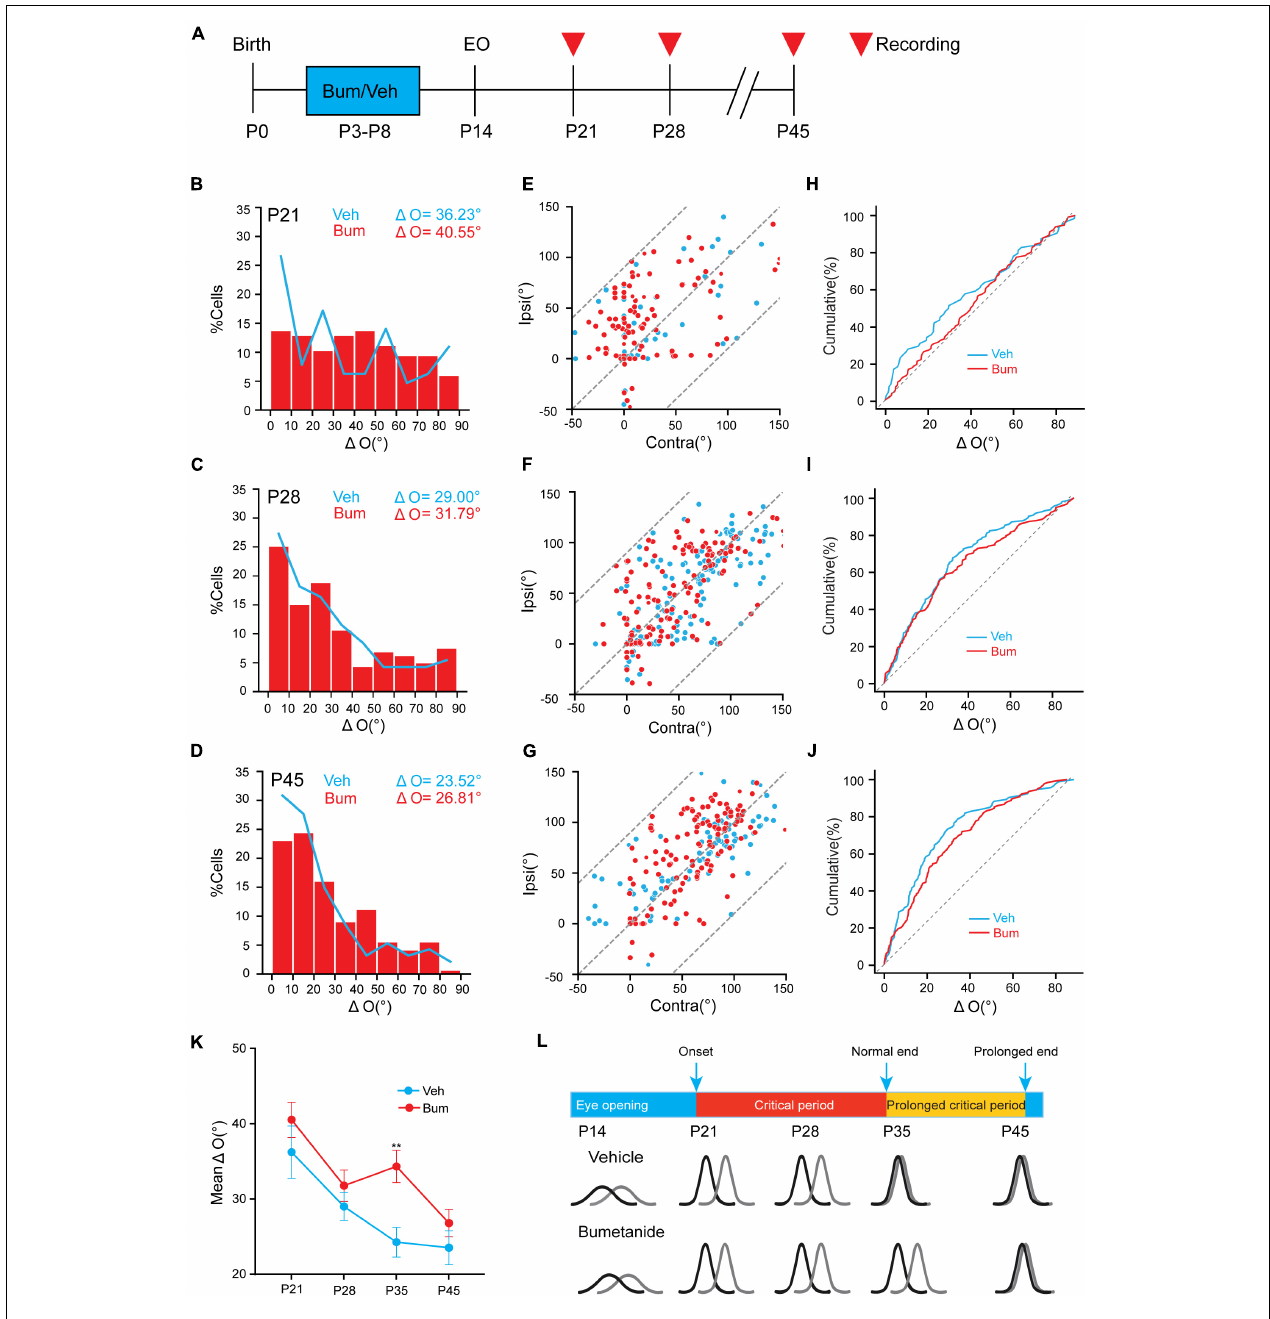
FIGURE 3 | Bumetanide treatment has no effect on binocular matching at other ages except for P35. (A) Schematic of three age groups (P21, P28, P45) recorded in Veh and Bum animals. Red triangle indicates in vivo electrophysiological recordings. (B–D) Distribution of difference in orientation preference in three different ages in Veh and Bum groups: (B) P21 in Veh (blue, (cid:49) O = 36.23 ± 3.46 ◦ , 65 cells,16 mice) and Bum groups (red, (cid:49) O = 40.54 ± 2.33 ◦ , 116 cells, 18 mice); (C) P28: in Veh ( (cid:49) O = 29.00 ± 1.86 ◦ ,165 cells, 11 mice) and Bum groups ( (cid:49) O = 31.79 ± 2.08 ◦ , 159 cells, 11 mice); (D) P45: in Veh ( (cid:49) O = 23.52 ± 2.24 ◦ , 94 cells, seven mice) and Bum groups ( (cid:49) O = 26.81 ± 1.80 ◦ , 143 cells, 11 mice); The data were binned at 5 ms from 0 to 1s. The same color pattern is followed in all figures. ( E–G) The correlation of preferred orientation of two eyes. (E) P21: orientation preferences are highly uncorrelated binocularly in the two groups (Veh: r = 0.48, p < 0.0001; Bum: r = 0.55, p < 0.0001, K-S test), and most points are discretely distributed. The dotted line defines the area where the data points are located. (F) P28: the correlation was better than P21 (Veh: r = 0.69, p < 0.0001; Bum: r = 0.64, p < 0.0001, K-S test). (G) P45: orientation preferences are highly correlated in the two groups (Veh: r = 0.79, p < 0.0001; Bum: r = 0.69, p < 0.0001, K-S test), and most points are close to the unity line. (H–J) Cumulative distribution of (cid:49) O between the two eyes in two groups (H) at P21, (I) P28, and (J) P45. (K) Mean (cid:49) O of visual cortical neurons in Veh and Bum mice at different ages. Mean (cid:49) O of